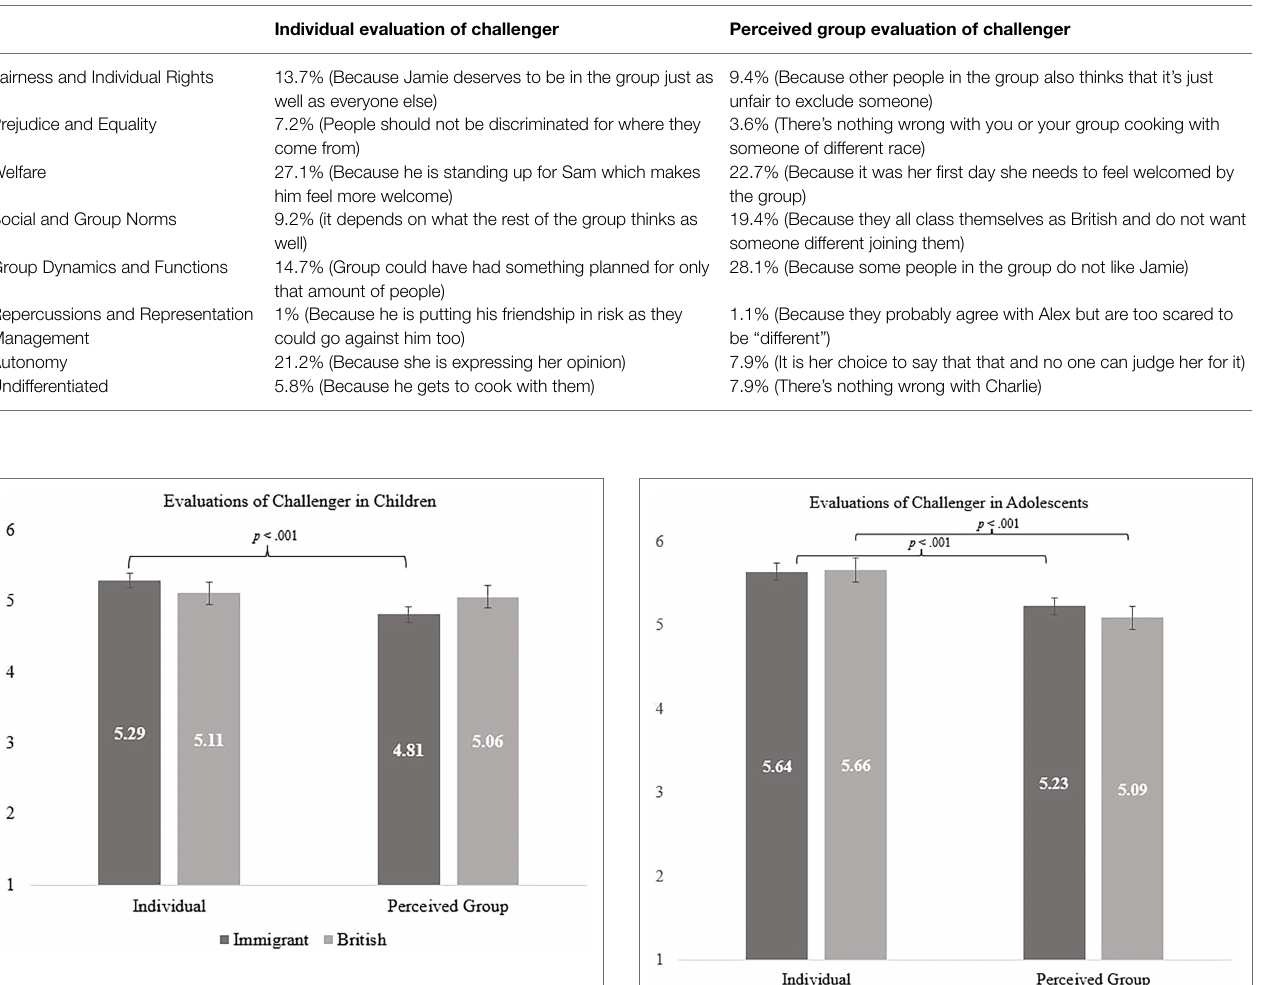
FIGURE 1 | Children’s individual and perceived group evaluations of challenger by exclusion